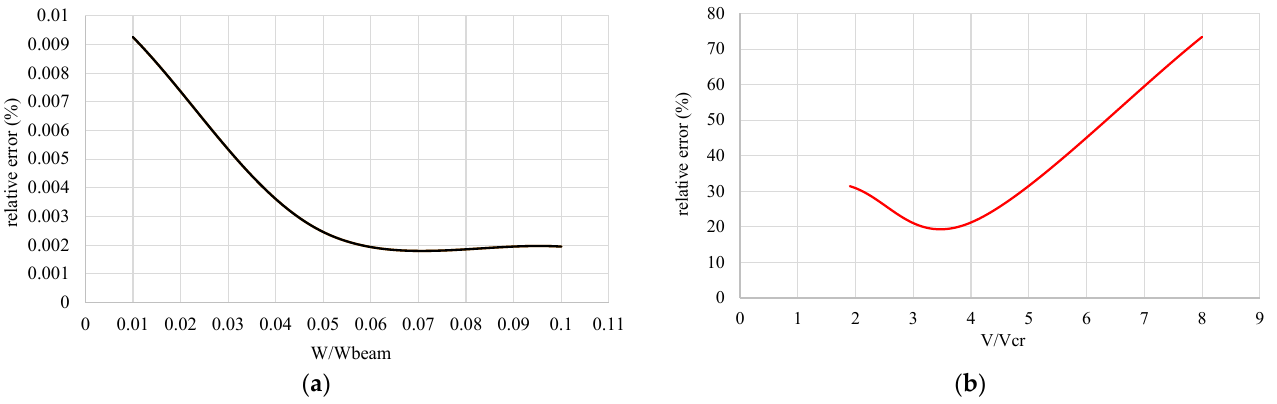
Figure 34. Moving load estimations using accelerometer sensors: ( a ) weight; ( b ) velocity estimation of the moving load.